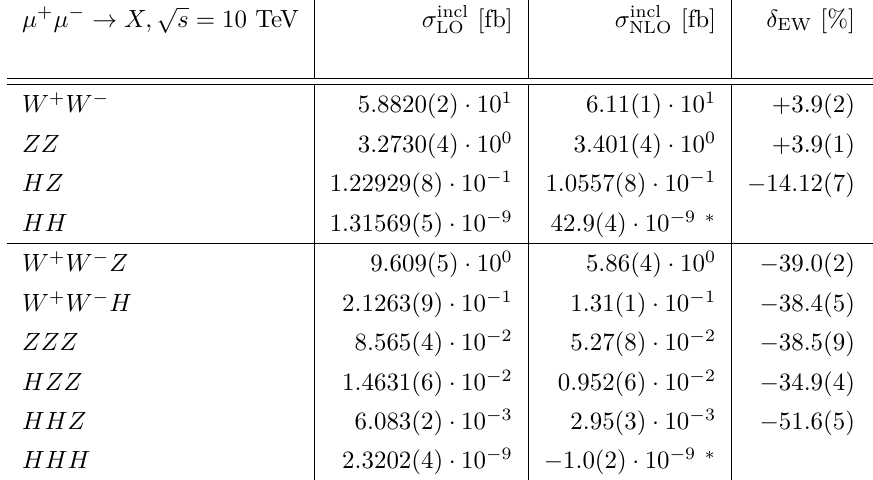
Table 2 . Total inclusive cross sections at LO and NLO with corresponding relative correction δ EW √ for di- and tri-boson production at s = 10 TeV. For (*), with dominant loop-induced contributions, we refer to remarks in the